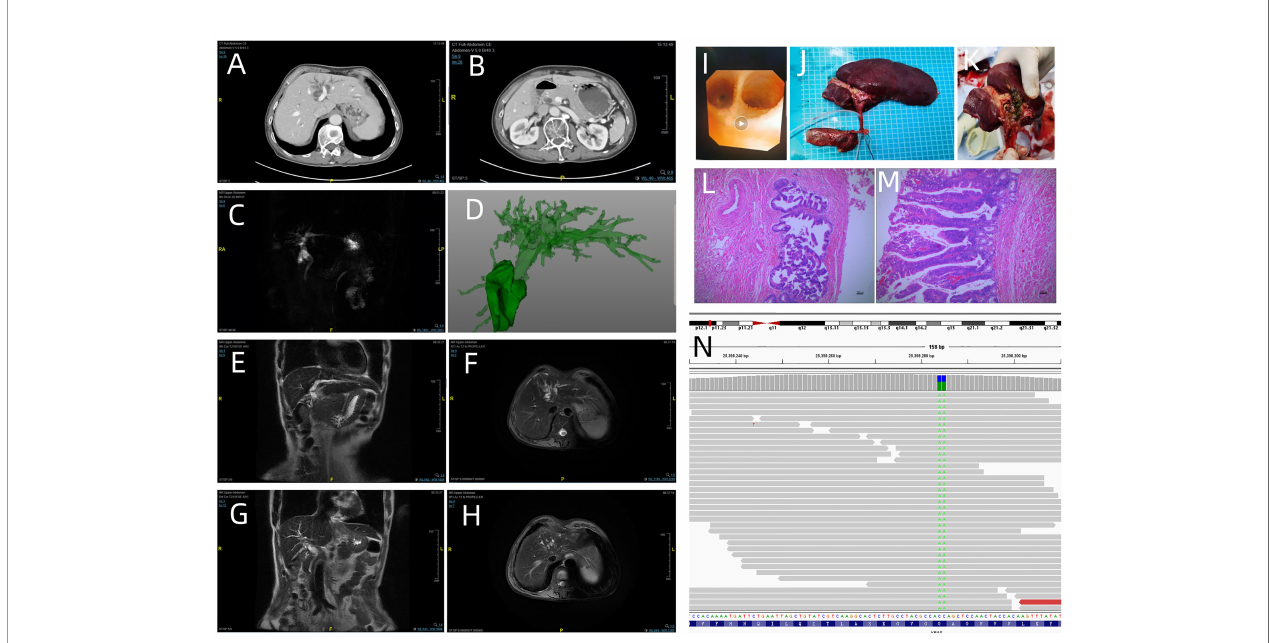
FIGURE 1 | Enhancedcomputed tomography showeddilatation of the intrahepaticbileduct in the leftlobeof the liver (A) and common bileduct (B) ; (C) (MRCP) and (D) (CT three dimensional reconstruction) revealed the dilatation ofextrahepaticand intrahepaticbileduct; (E) (coronal view) and (F) (axial view).Irregular dilatation andthickening of the bileduct are visiblein the lefthepaticlobe; (G) (coronal view)and (H) (axial view)show dilatation ofthe bileduct in the right lefthepatic lobe. (I) Intraoperative cholangioscopy fi ndings: biliary papillomatosis inthe lefthepaticduct. (J, K) Macroscopic fi ndings: the bileduct is fi lled with greenish- yellow mucus- likesludge. ( L : magni fi cation, x40 and M : magni fi cation, x100; hematoxylin and eosin staining)Microscopic fi ndings: the intrahepatic bile duct, common bileduct and cysticduct were lined bypapillarygrowth neoplasiawith high-gradeintraepithelialneoplasia. (N) Next-generation sequencing results revealed the mutation of KRAS codon 12